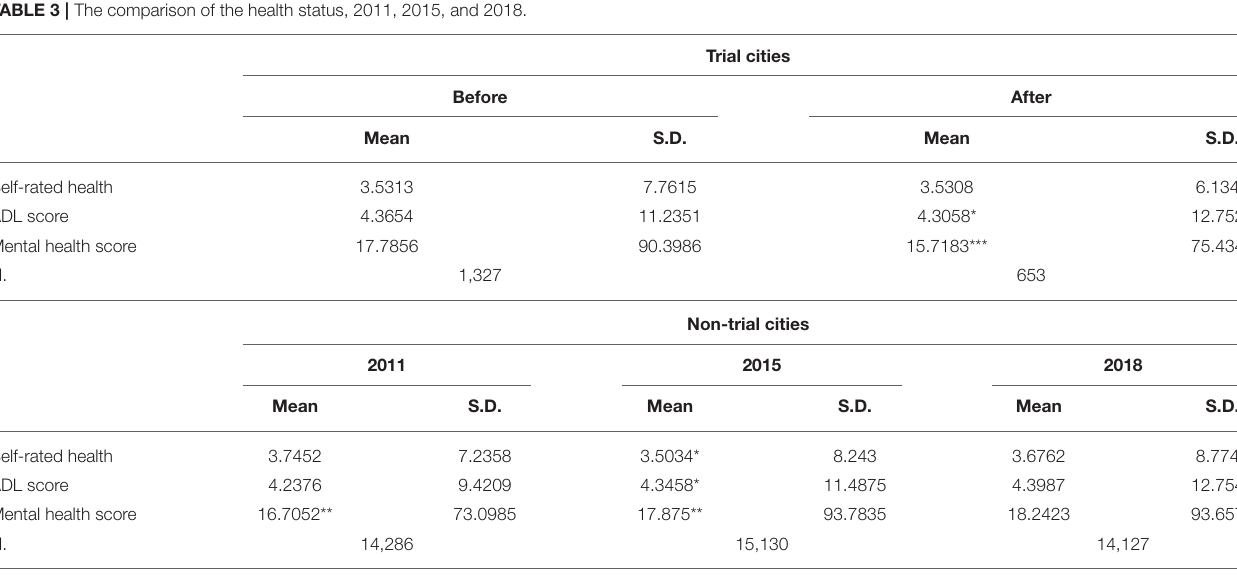
TABLE 3 | The comparison of the health status, 2011, 2015, and